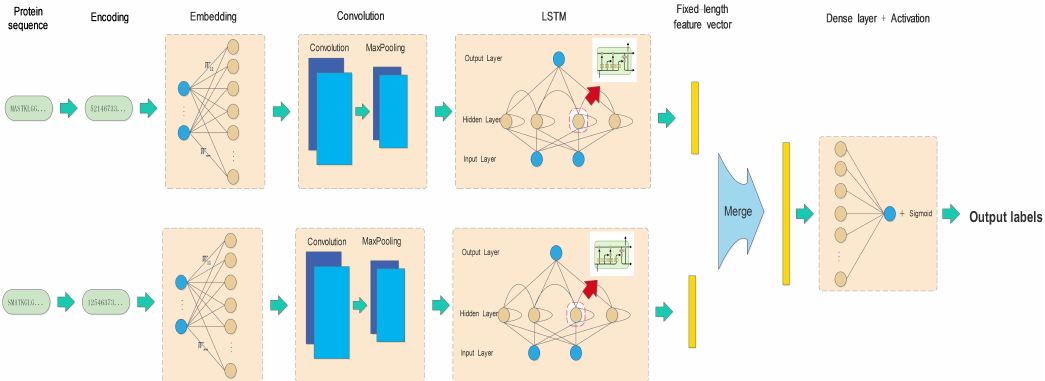
Figure 1. Architecture of the deep learning